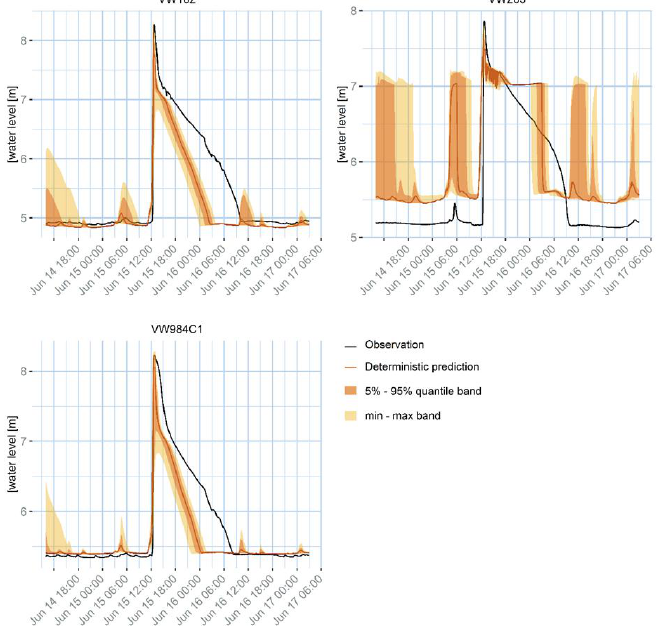
Figure 8. Using the rainfall ensemble as an input for the InfoWorks model, an ensemble of water level estimations is obtained. The ensemble is compared with the observations at three different locations. The ensemble is represented with the deterministic prediction (kriging mean), with the 5–95% quantile band, and the minimum–maximum